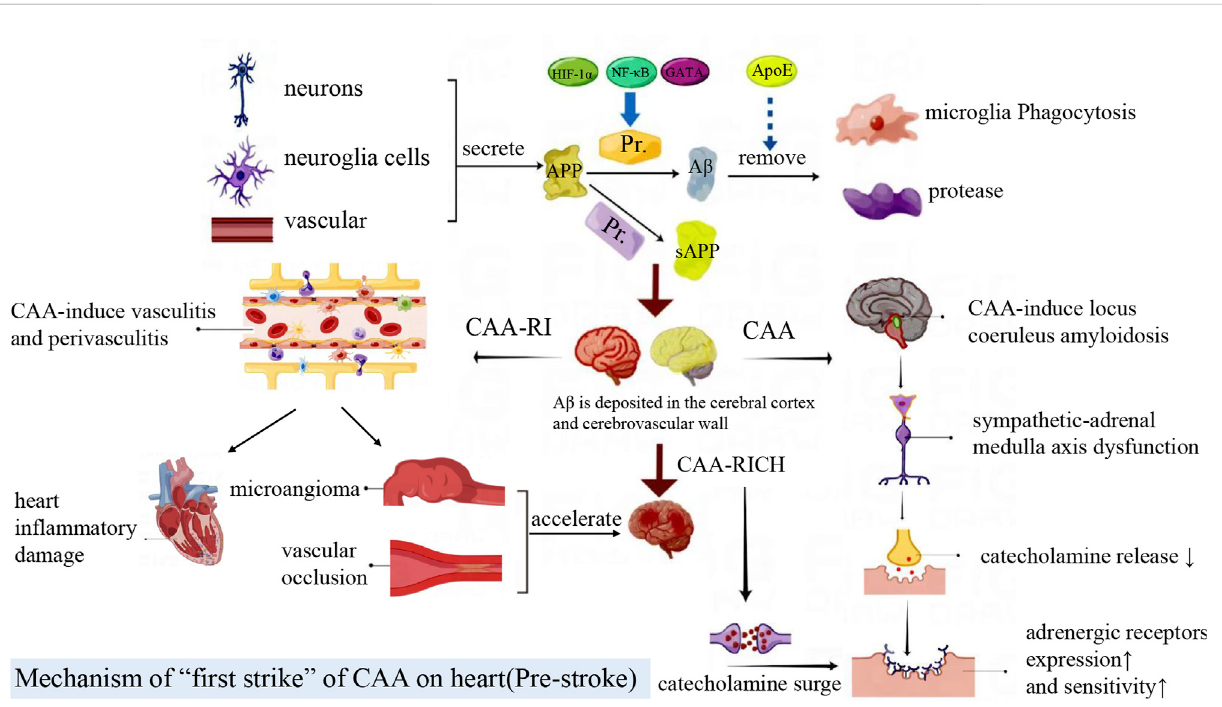
FIGURE 2 Amyloid precursor protein (APP) is mainly produced by neurons, glial cells and blood vessels. It is cleaved by enzymes to produce A β or sAPP fragments, which are cleared by macrophages and proteases. A β is deposited in the brain parenchyma, blood vessels and cells. Locus coeruleus amyloidosis impairs the sympathetic-adrenal medulla axis and cardiac autonomic function, then further leads to the increased adrenergic receptor expressionandactivity,whichexacerbatesheartinjuryafterCAA-RICH.CAA-relatedvasculitisandperivasculitiscanleadtoin fl ammatorydamagein the heart. At the same time, CAA-RI increases vascular fragility and conversely accelerates the CAA-RICH